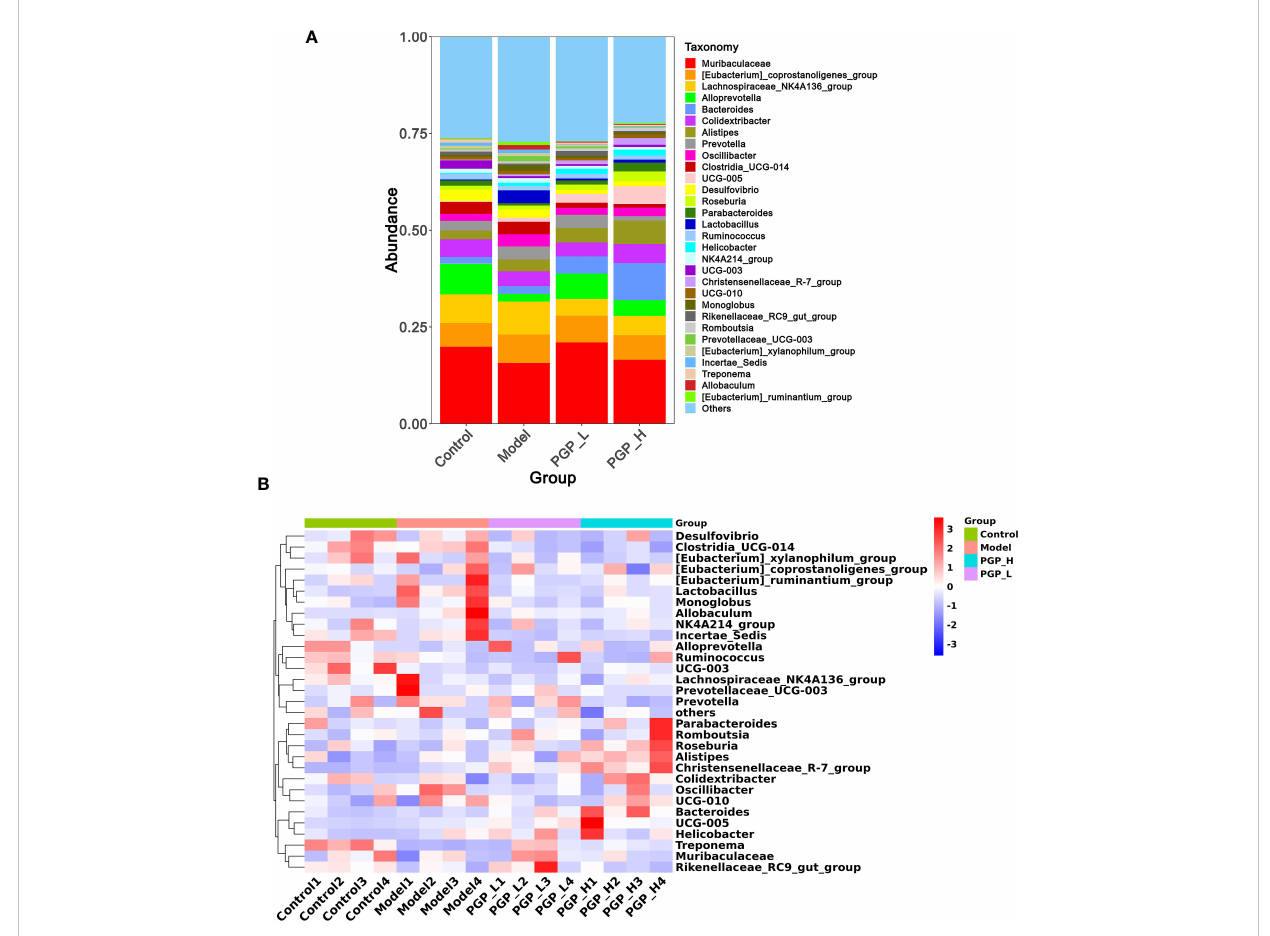
FIGURE 6 Structure of the gut microbiota at the genus level. (A) Cumulative histogram of species at the genus level. (B) Clustering heat map of species at the genus